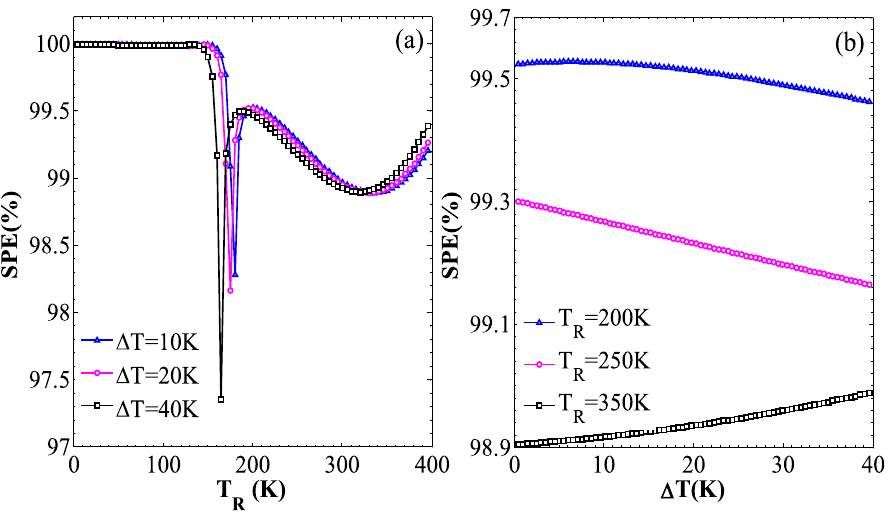
Figure 7. ( a ) The variation of the spin polarization efficiency (SPE) versus T R for ∆ T = 10, 20, and 40 K ( b ) the SPE variation versus Δ T for T R = 200, 250, and 350